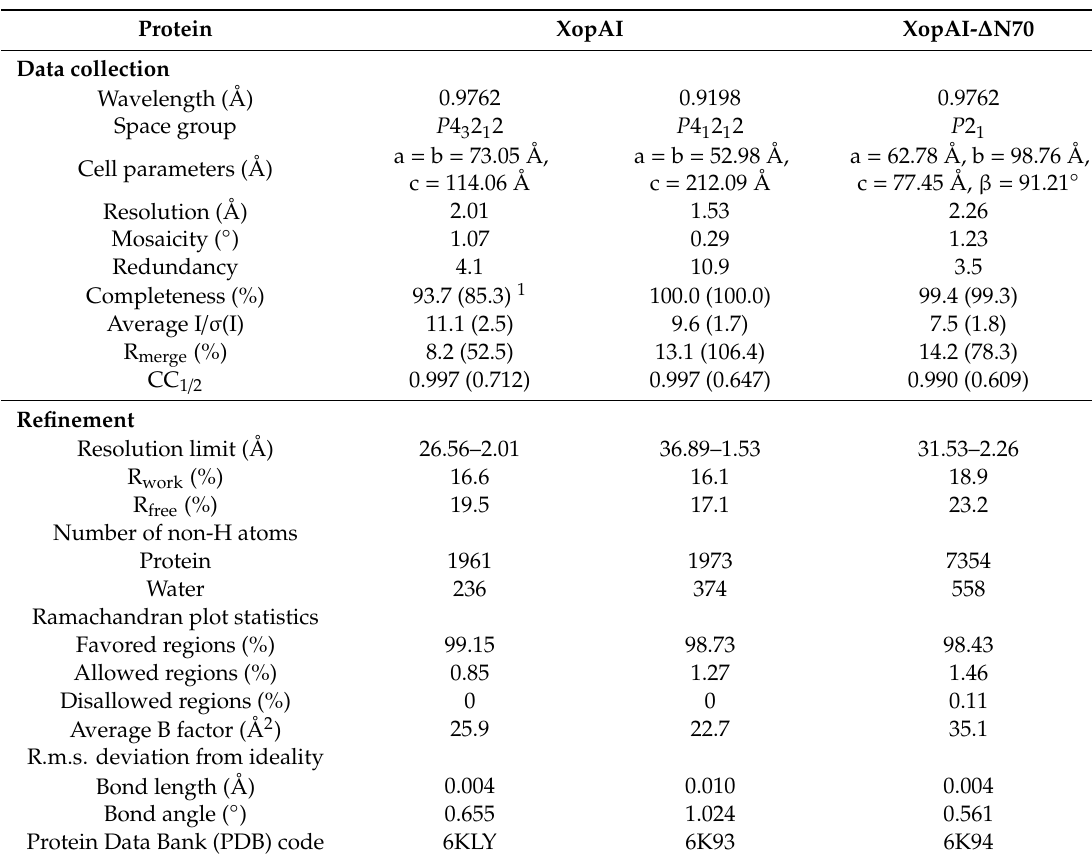
Table 2. Data collection and refinement